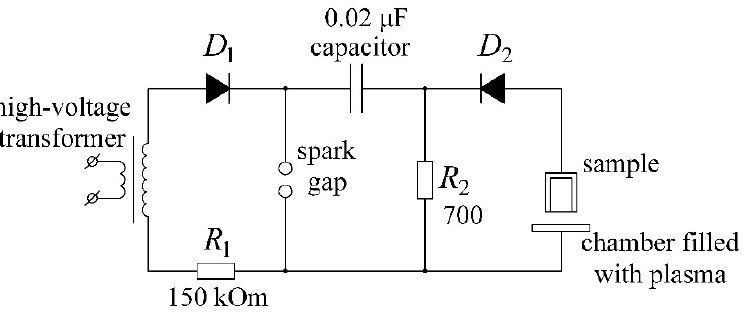
Figure 3. Scheme for generation of high-voltage pulses between the sample and plasma. The oscillograms of voltage pulses on the sample in the absence of plasma in the chamber at a pressure of 0.002 Pa showed that, with the indicated circuit parameters, the width of the leading edge of the pulse is 0.5 µs, which is 10 times less than when using a high-voltage pulse generator. After filling the chamber with argon to a pressure of 0.5 Pa and applying a voltage of ~500 V to the anode, the chamber was filled with a uniform glow discharge plasma, and bright sparks appeared on the surface of the sample immersed in the plasma, similar to the cathode spots of a vacuum arc [22,23]. A minute later, the window on the chamber wall darkened and had to be covered with a shutter. After treatment of an 8-cm-long hollow cylindrical sample made of Co-Cr-Mo for 30 min with pulses at a repetition rate of ~40 Hz, its surface became smooth and matte. There were no large protrusions on it, and the roughness of both the outer and inner surfaces measured using a HOMMEL TESTER T8000 profilometer by Hommelwerke GmbH (Germany) ranged from Ra = 0.9 µm to Ra = 1.2 µm. The porosity was almost completely eliminated. Hence, the microexplosions not only destroy protrusions on the sample surface, but also, as a result of surface melting, eliminate micropores on it. According to the experimental results, the energy stored in a 0.02 µF capacitor charged to 10 kV, approximately equal to 2.5 J, can be considered the optimal value of the pulse energy. Explosive ablation of protrusions on the surface of a sample immersed in plasma is an analog of electroerosive grinding, which uses electroerosive metal destruction. It essentially differs in that there is no dielectric medium or any electrode tool, the approach of which to the sample surface should lead to a breakdown between them with the formation of a dense plasma channel and local destruction of the sample surface. In our case, breakdowns between the plasma and the sample immersed therein are similar to the formation of plasma torches on the cathode surface of electron guns with explosive electron emission and are determined by the size and location of microscopic protrusions on the sample surface. 3.2. Polishing with a Beam of Fast Argon Atoms Beam polishing is effective only at large angles of incidence of fast atoms on the treated surface α = 75–85°. In the case of flat substrates, it is quite simple to create the necessary processing conditions. It is only necessary to install the substrate on a holder rotating in the vacuum chamber in such a way that the angle of incidence of fast atoms on its surface is equal to the specified value. For products of complex shape with cavities, polishing at large angles of incidence of fast atoms on the surface to be treated α = 75–85° requires new technical solutions. For example, an 8-cm-long hollow cylindrical sample, with an outer diameter of 6 cm and an inner diameter of 5 cm, after explosive ablation of protrusions on its surface for 30 min, was treated with a ribbon beam of fast argon atoms. For this, the positive pole of the discharge power source was disconnected from the anode of the rectangular chamber using a switch and connected to the anode of the cylindrical chamber. When a voltage U d